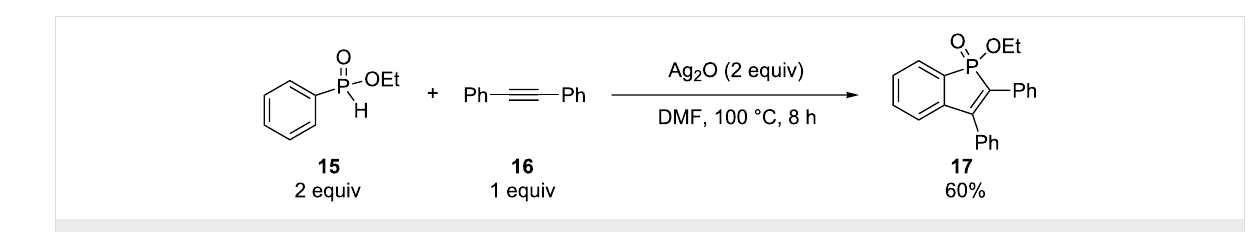
Scheme 7: Silver oxide-mediated alkyne–arene annulation.